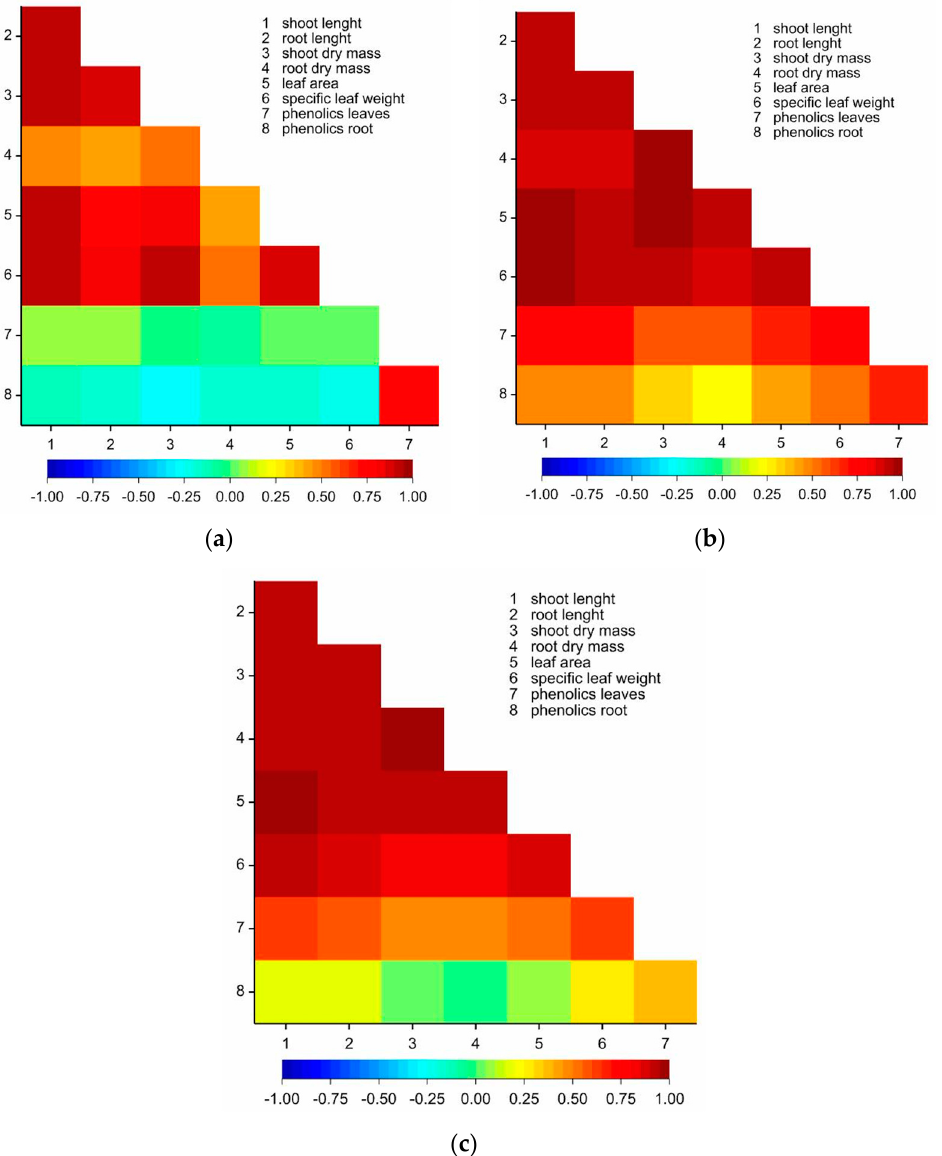
Figure 2. Heatmap for linear Pearson’ correlation coefficients between observed parameters in ( a ) vermiculite ( r 0.05 = 0.201); ( b ) soil 1 ( r 0.05 = 0.201); and ( c ) soil 2 ( r 0.05 = 0.201).